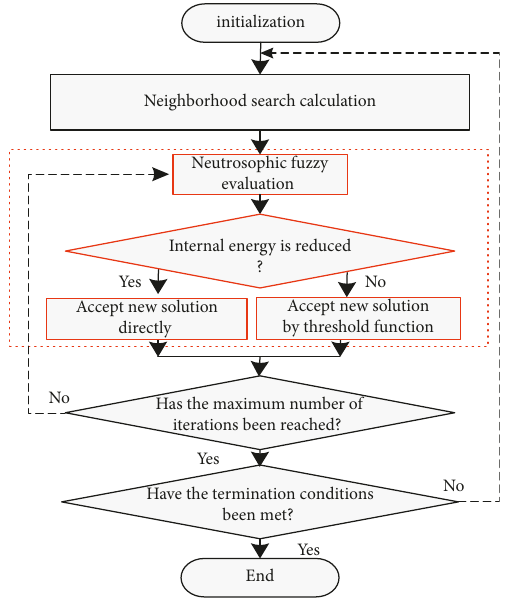
Figure 3: Technical roadmap of NSAA.